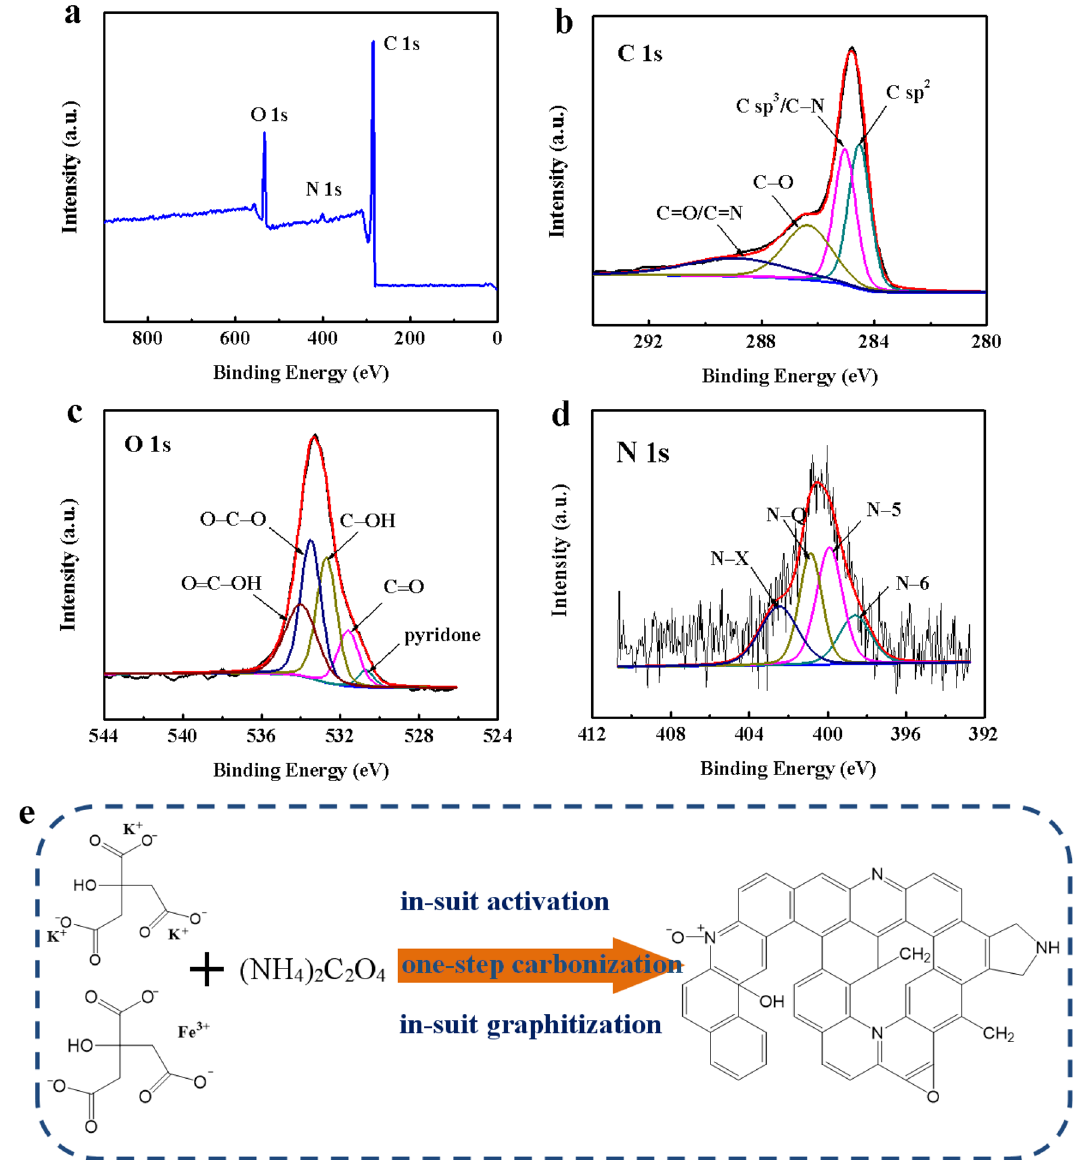
Figure 5. ( a ) XPS survey of HPGC-750; high resolution XPS spectra of ( b ) C 1 s, ( c ) O 1 s, and ( d ) N 1 s for HPGC-750; ( e ) synthetic route to the fabrication of HPGC- T by direct pyrolysis potassium citrate and iron citrate. The synthetic route was drawn using Powerpoint 2019 (https:// www. micro soft. com/ zh- cn/ micro soft- 365/ get- start ed- with- office-